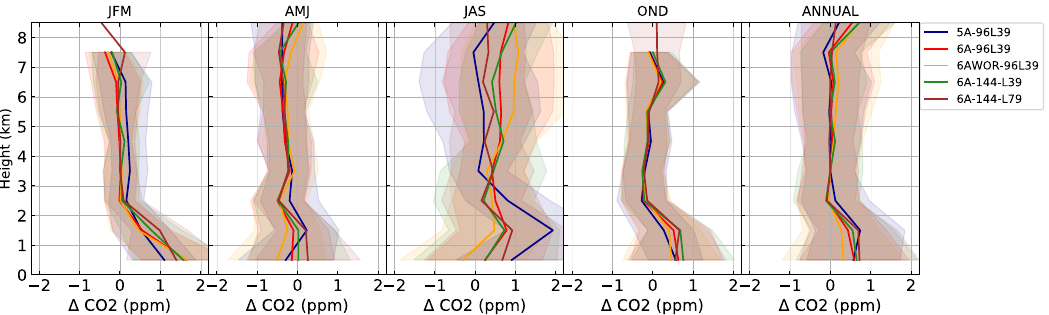
Figure 10. Bias (model–observations, thick lines) and associated standard deviation (shaded areas) for the monthly CO 2 vertical profile differences over North America during the period 2008–2014. The data have first been averaged in 1km altitude bins per hour and per site, before being averaged among the 12 North American sites of Fig. 1 per month. The statistics are drawn from that ensemble of monthly and spatially averaged values. They are shown for each season (January–March, JFM; April–June, AMJ; July–September, JAS; October– December, OND) and for the whole year. In order to highlight the differences in profile shape, the annual mean of the bias at 3.5km has been removed for each simulated vertical profile (5A-96L39: − 2 . 0ppm, 6A-96L39: − 2 . 0ppm, 6AWOR-96L39: − 2 . 0ppm, 6A-144L39 and 6A-144L79: 1.3ppm).